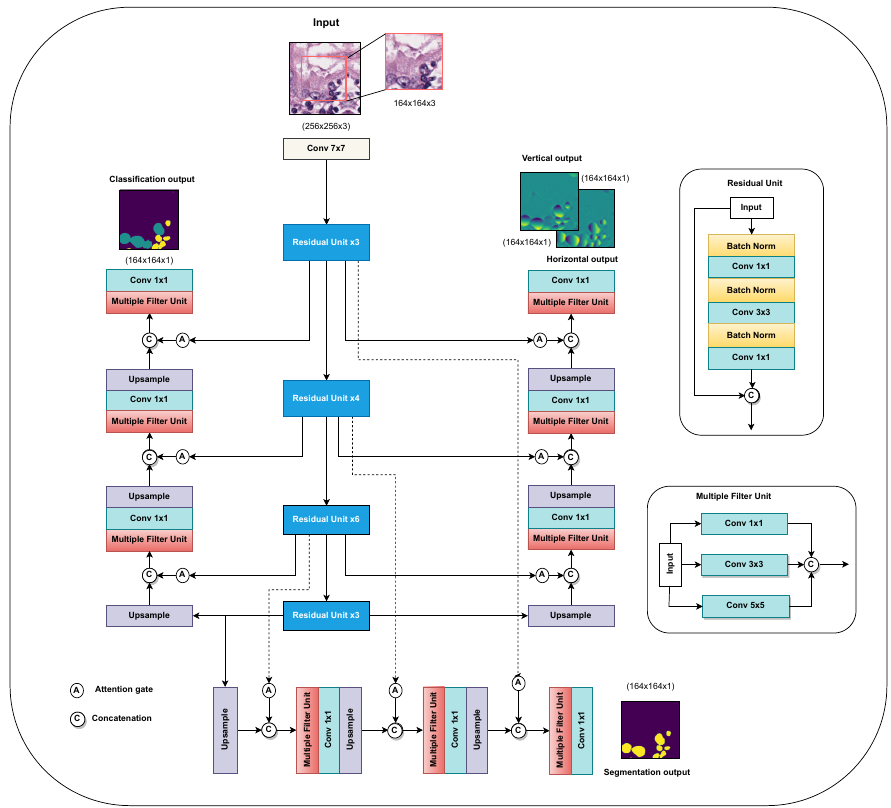
Figure 1. Schematic of our proposed method. The proposed method adopted to solve the problem, combining the HoVer-Net model [17] and a multiple filter unit [18], is named